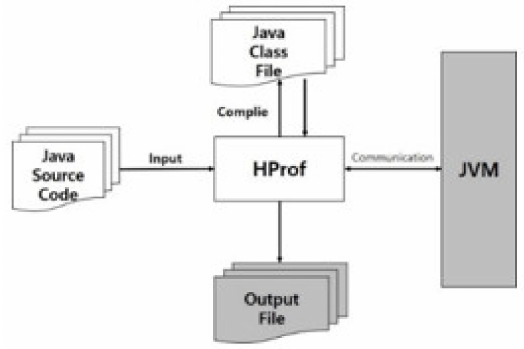
Figure 6. HProf execution process. JVM, Java virtual machine.